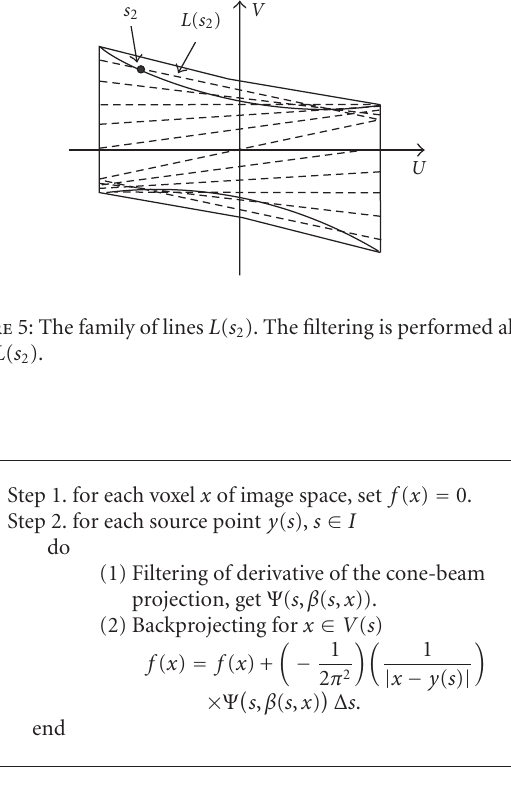
Figure 4: Cone-beam cover V ( s 0 ). Let (cid:14) V ( s 0 ) be the cone with vertex (cid:15) W ( s V ( s U . y ( s = (cid:14) V ( s 0 ) and base 0 ), then 0 ) 0 )